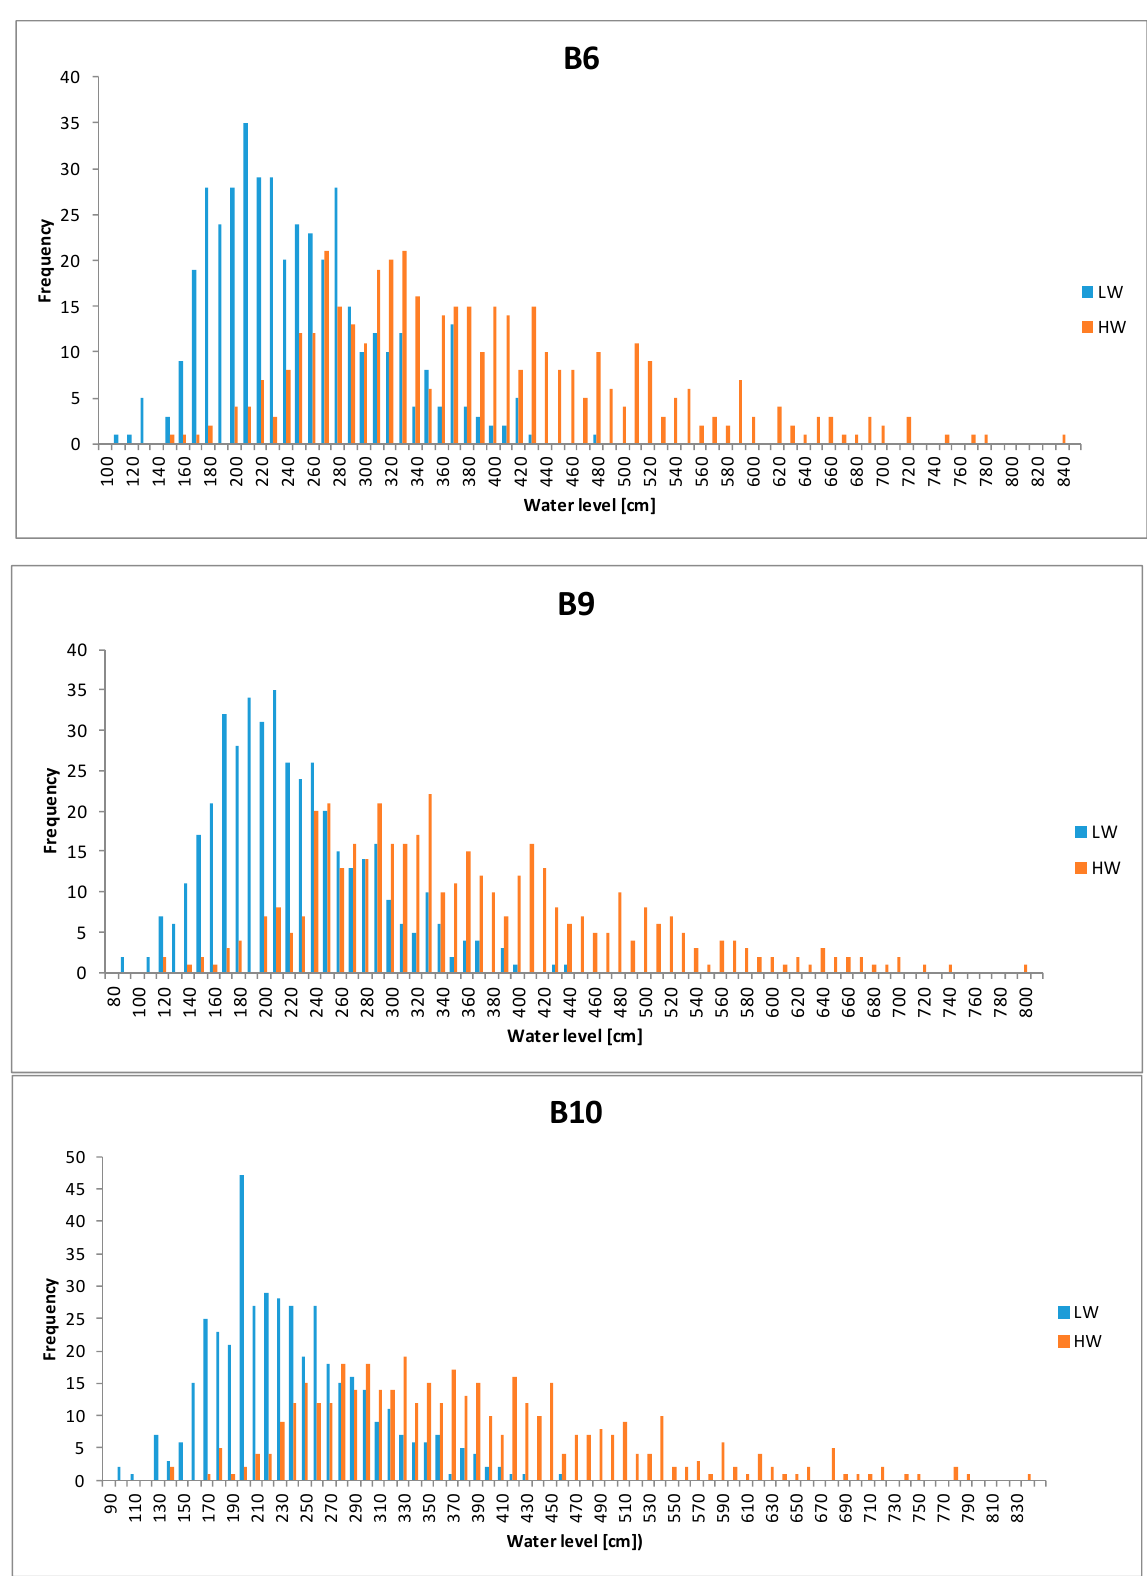
Figure 2. The frequency of high (HW) and low water (LW) levels in the Vistula River measured at gauging stations Grudzi ą dz (B6), Fordon (B9), and Toru ń (B10) between 1981–2016. Table 2. Bridge parameters are important for safe navigation—on a stretch of the Vistula River from the estuary to Warsaw.